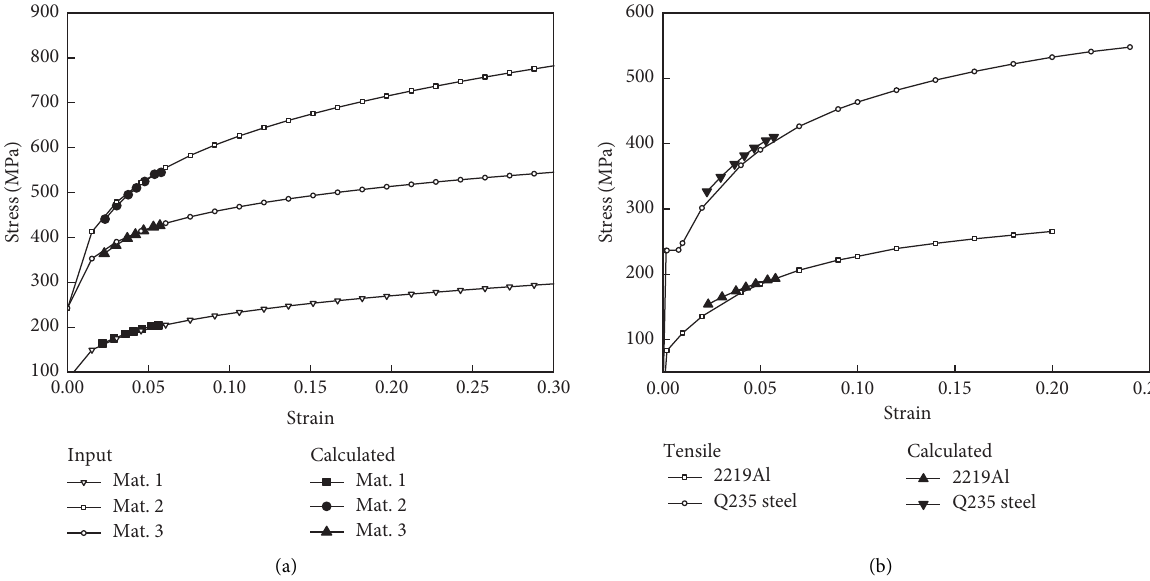
Figure 6: Comparison between input or tensile curves and stress-strain points calculated by the reverse analysis: (a) 3 imaginary materials; (b) 2219Al and Q235 steel.